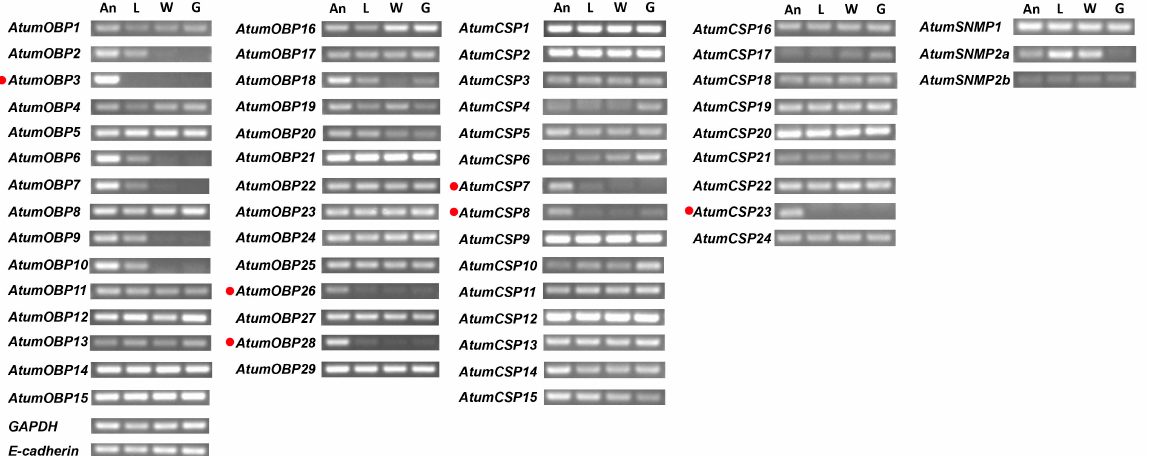
Figure 7. Expression profile of OBPs, CSPs and SNMPs in different tissues. Genes specifically or mainly expressed in antennae are marked with red dots. GAPDH and E-cadherin genes were used as internal reference to test the integrity of each cDNA template. A, antennae; L, foreleg tarsus; W, wings; G, genitals.